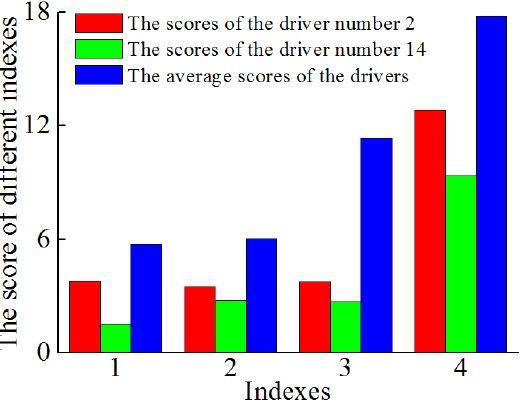
Figure 18. The evaluation result of driving behaviour: ( a ) The score distribution of driving events; ( b ) The score for every driver.